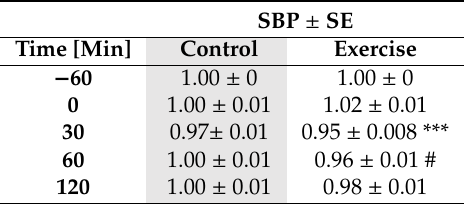
Table 2. Mean fold-changes in systolic blood pressure in the control and the exercise intervention compared to baseline ( − 60 min). For a better comparison, the baseline values were set to 1; absolute values can be found in Supplementary Table S1. *** p < 0.001 compared to baseline of the same intervention, repeated measures ANOVA, # p < 0.05 comparison between control and exercise intervention (repeated measures ANOVA with pairwise comparisons of exercise and sedentary control) and Bonferroni-correction for multiple testing ( n = 18). Abbreviations: SBP: Systolic blood pressure SE: standard error of the